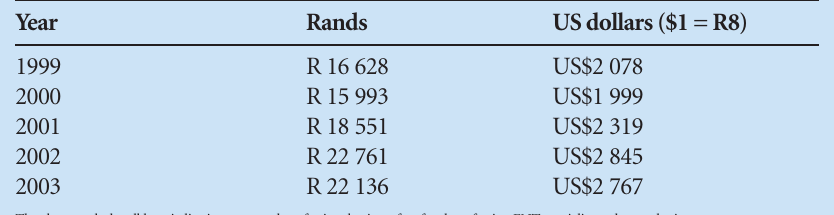
Table VI. Average costs per embolisation